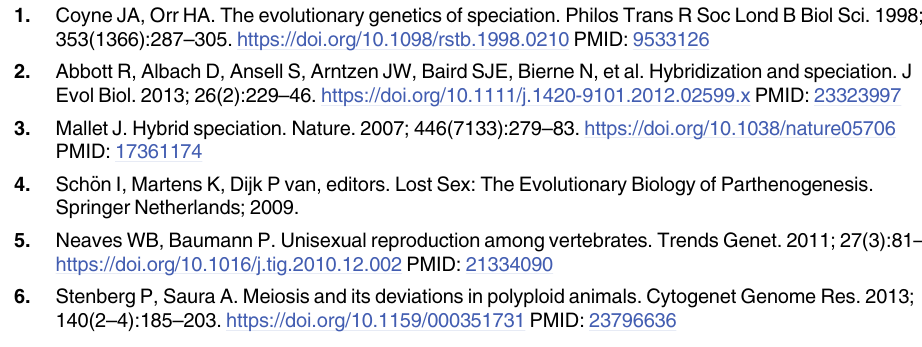
S2 Table. Analysis of gonads dissected from tadpoles with identification of genome in the micronuclei. Tadpoles obtained from crosses of parental individuals (marked orange), two P . lessonae individuals (marked red) and P . lessonae individuals and hybrids from L-E systems (marked blue) and R-L-E systems (marked green). S1 Fig. Identification of P . ridibundus lampbrush chromosomes using FISH for the centro- meric RrS1 repeat. Lampbrush chromosome sets, including 26 univalents (a) and 26 bivalents (b), among which 13 uni- or bivalents have a signal in the centromeric region, thus corre- sponding to P . ridibundus chromosomes; another 13 uni- or bivalents do not have a signal in the centromeric region, thus corresponding to P . lessonae chromosomes. The chromosomal set represented in S1A Fig corresponds to Fig 3B . The chromosomal set represented in S1B Fig corresponds to Fig 3C .